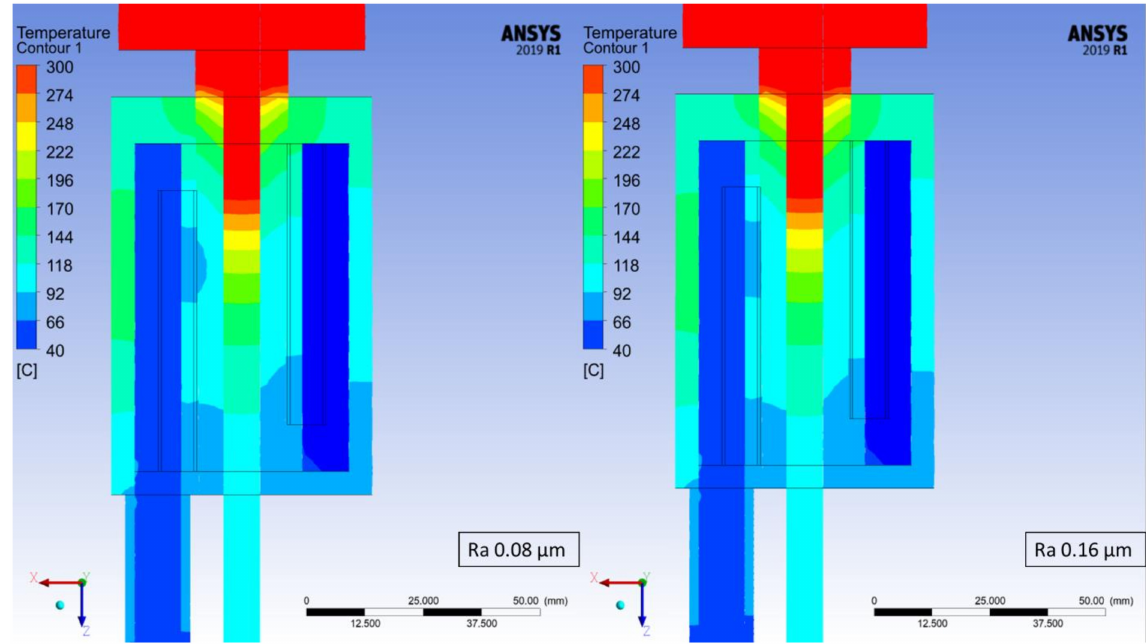
Figure 6. Continuous casting process simulation for the crystallizer with Ra 0.08 µ m ( left ) and Ra 0.16 µ m ( right ); step 900 of the simulations (450 s).